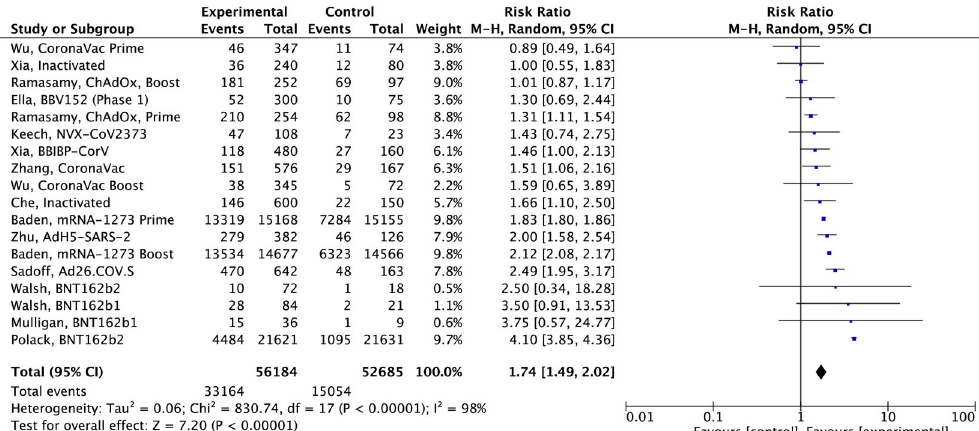
Fig. 2 Forest plot analysis of the overall incidence of solicited adverse events (AE) in 15 human studies. A risk ratio of >1 is indicative of a higher incidence of AE in experimental compared to control groups. A Mantel – Haenszel variance random effects model (CI) was employed to estimate effects between experimental and control groups correcting for confounding variables. I 2 statistic, 95% CI and point estimates are displayed for each individual study.